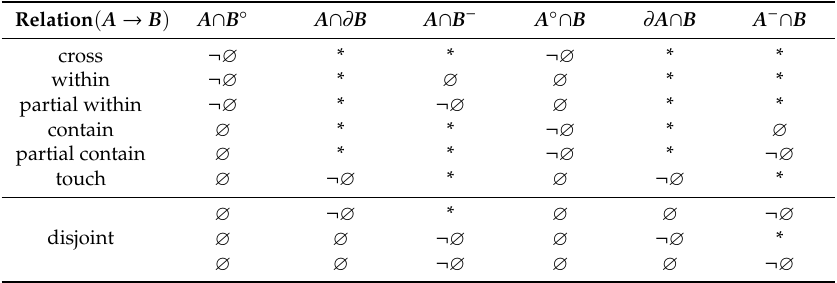
Table 1. The definition of the spatial topological relations between two point